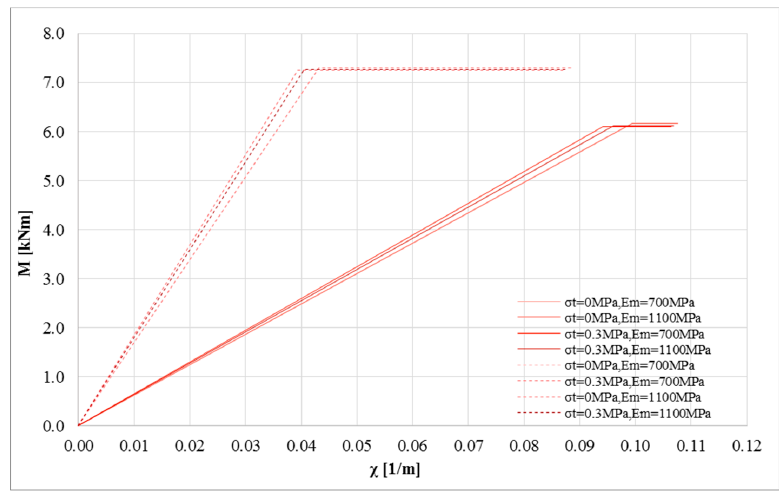
Figure 9. Bi-linearized M- χ curves: P = 0 N, σ 0 = 1 MPa, σ t = 0 and 0.3 MPa, E m = 700 and 1100 MPa for linear (solid lines) and bi-linear (dotted lines) relationships for the strengthening system (basalt